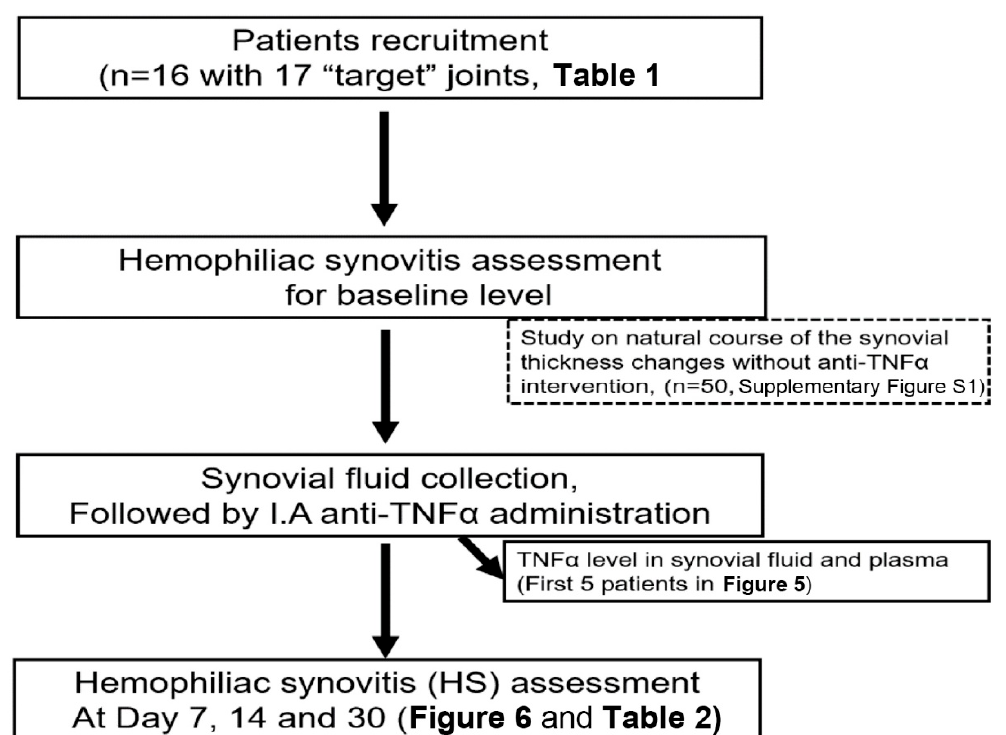
Figure 2. The consort diagram for patients study. I.A, intra-articular.